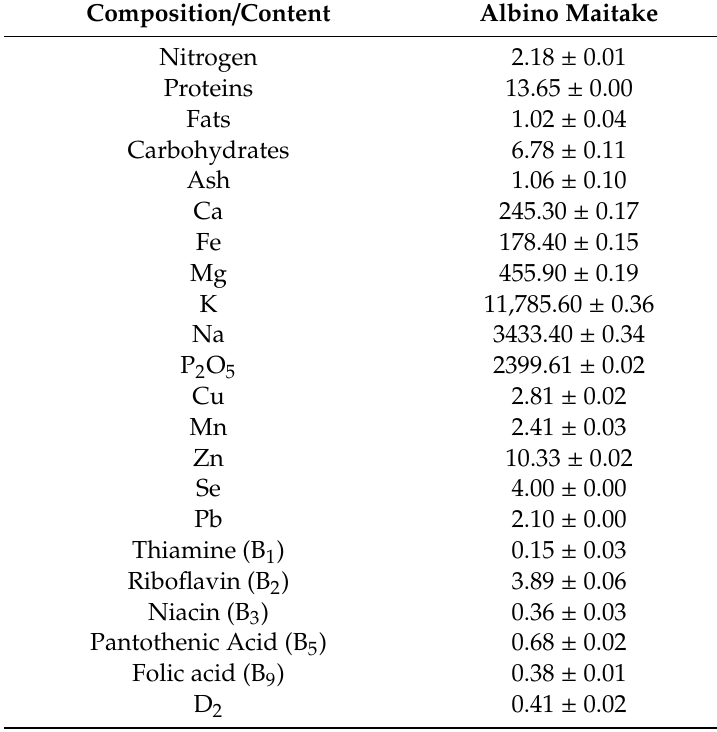
Table 2. Outcome of proximate composition analysis (% for nitrogen, proteins, fats, carbohydrates, and ash), and content in elements and vitamins (mg · 100 g − 1 ) of the albino maitake specimen. Values are expressed as means ± standard error, n =